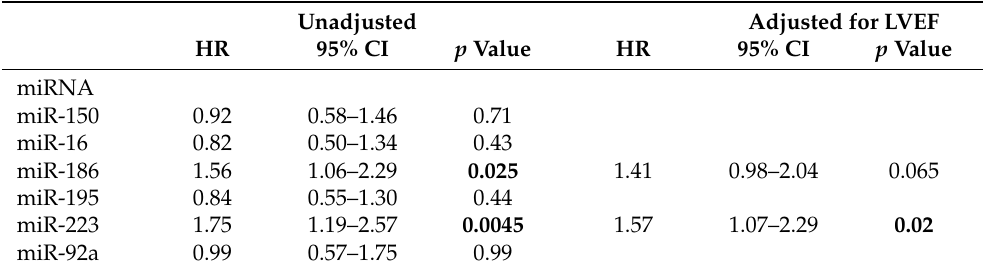
Table 5. Prognostic effect of miRNAs on all causes of death in MI patients assessed by Cox regression